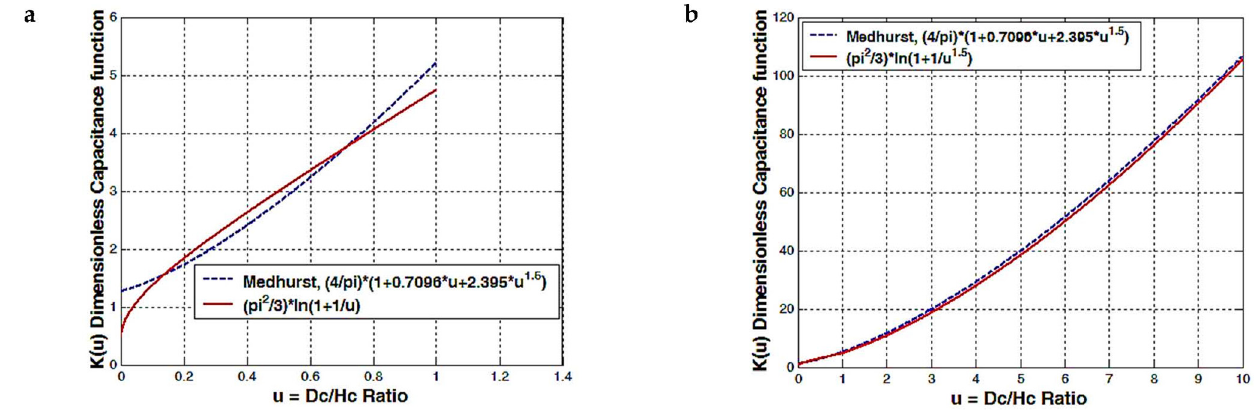
Figure 3. Coil capacitance dimensionless function (factor), comparison between the Medhurst formula and our theoretical logarithmic function; ( a ) 0 < u < 1, m = 1 and ( b ) u > 0, m = 1.5. Table 1. RF inductors measured self-capacitance compared to the calculated Medhurst and our logarithmic formulas.